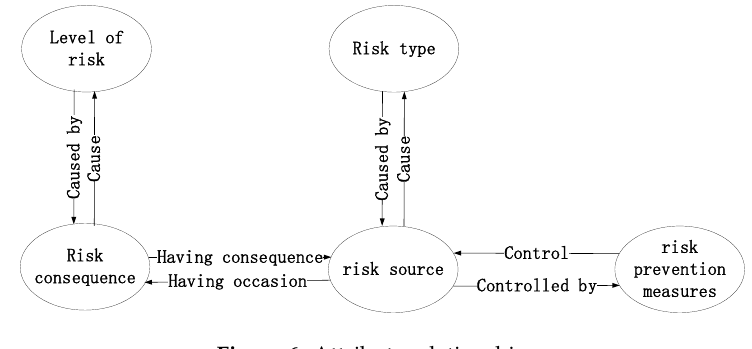
Figure 6. Attribute relationships.